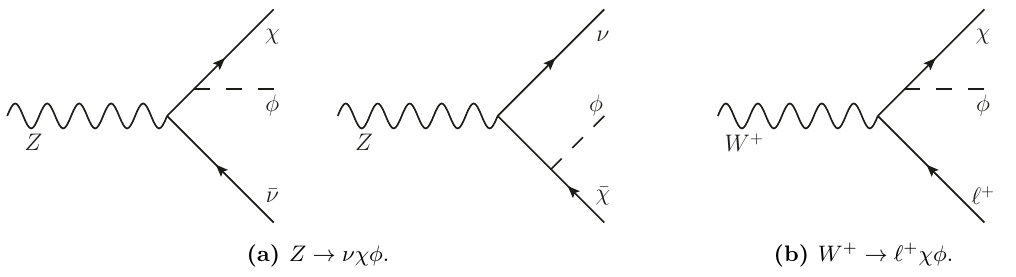
Figure 4. The diagrams contribute to (a) the invisible decay of the Z and (b) the mono-lepton decay of the W + for the case of fermionic DM. Similar diagrams for the case of scalar DM can be obtained by making the replacement (cid:31)